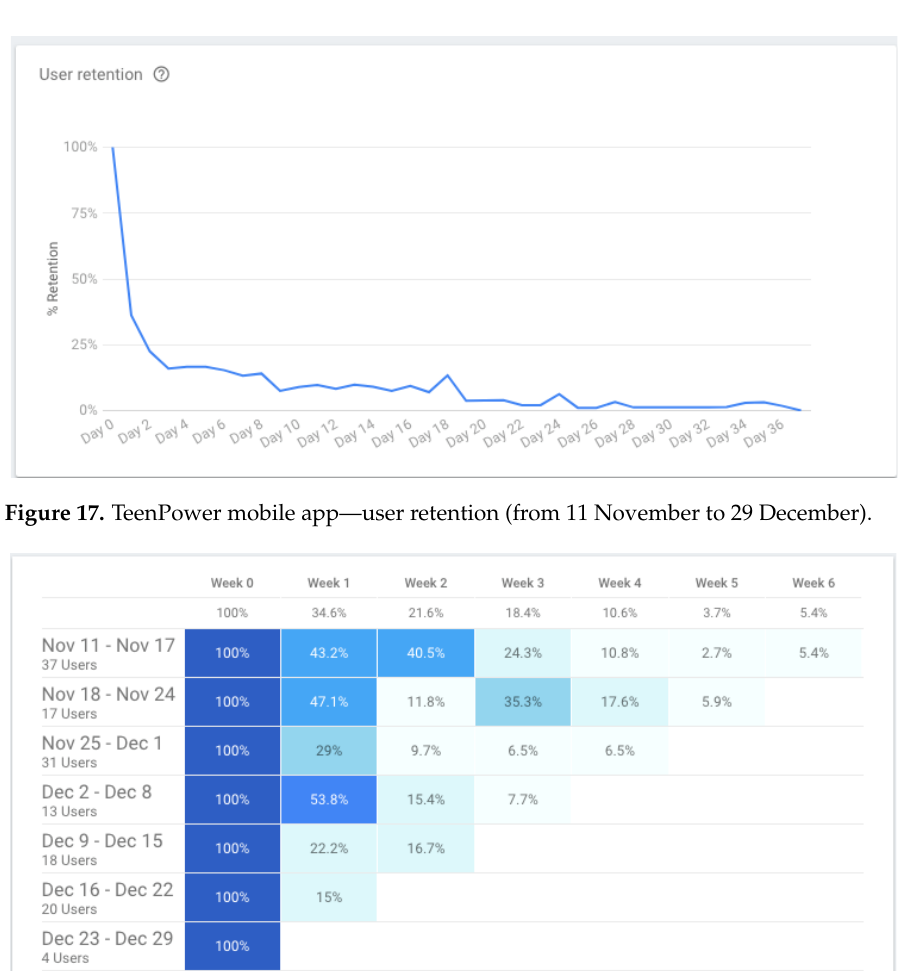
14 of 22 Figure 16. TeenPower mobile app — active users (30-day period starting on December 4, 2018). The retention rate dropped along a 36 day-period that started on 11 November (Fig- ure 17). On the second day, the immediate user retention rate had already dropped below 25% (less than 22 users out of 90). The rate illustrates two peaks that are ultimately related to intervention kickoff sessions to present the mobile application to new sets of users. The last value registered for the user retention rate was nearly 2% (2 users out of 90).